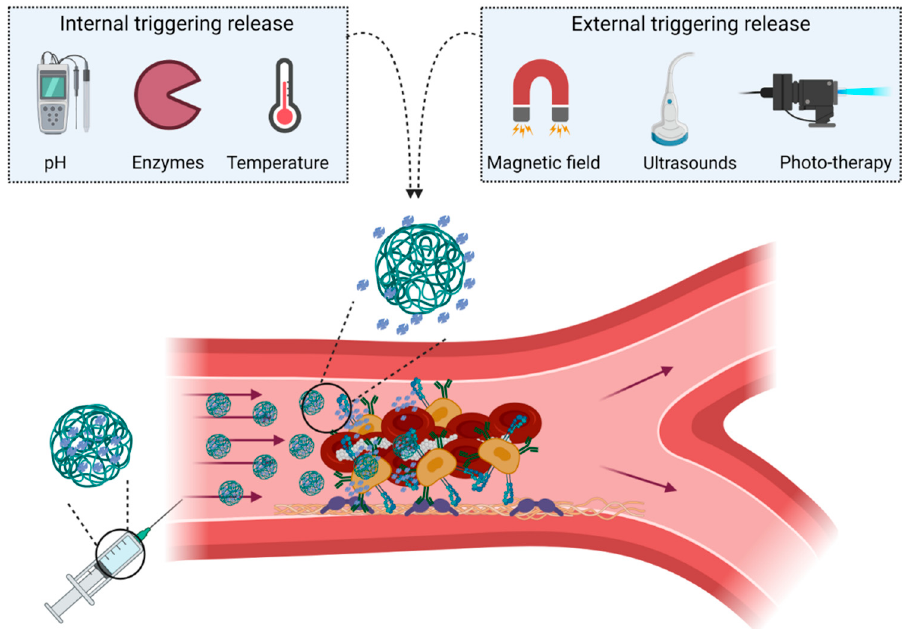
Figure 7. Stimuli-responsive nanosystems. The release of the nanosystems in the desired area can be triggered by internal and/or external stimuli. Enzymes, pH, and temperature are the most common examples of internal stimuli. Externally, the release can be triggered by magnetic fields, ultrasound, or photo-therapy. Figure created with BioRender.com.